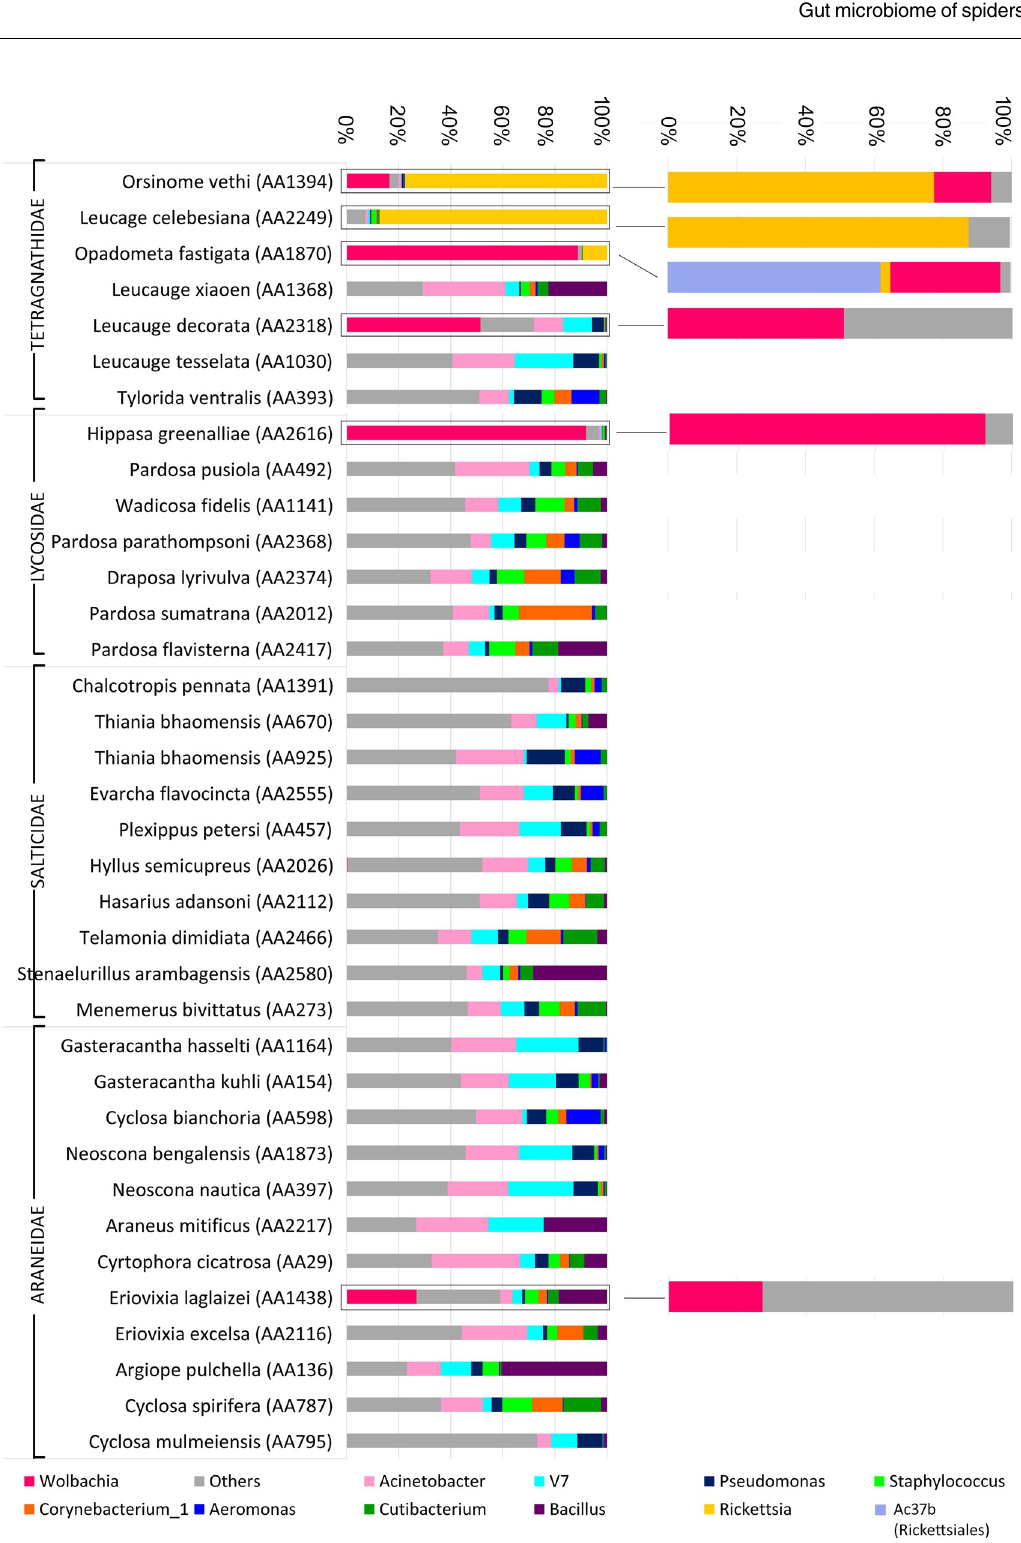
PLOS ONE | https://doi.org/10.1371/journal.pone.0251790 July 21,